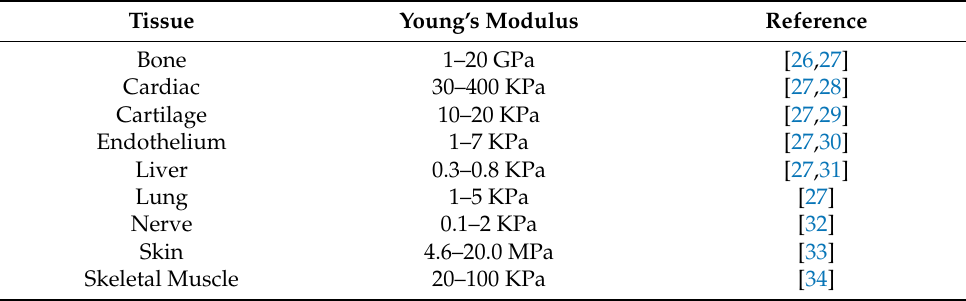
Table 1. Young’s modulus of various tissues.